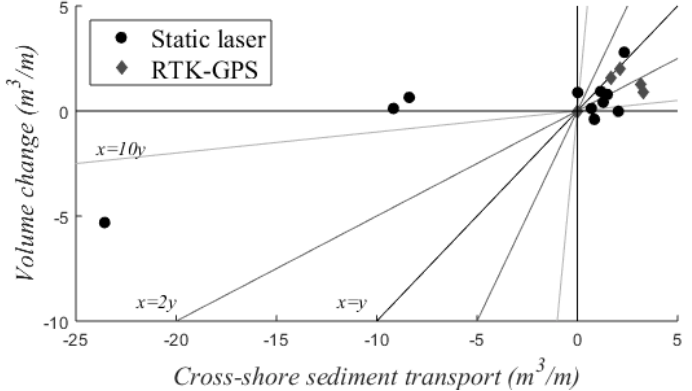
Figure 12. Cross-shore sediment transport per m beach width compared to the observed intertidal beach volume change. Points represent one day each. Lines represent a 1:1 relationship between cross-shore sediment transport and beach volume change (black) and 2x (dark grey) and 10x (light grey) over- and underestimation of the volume change.